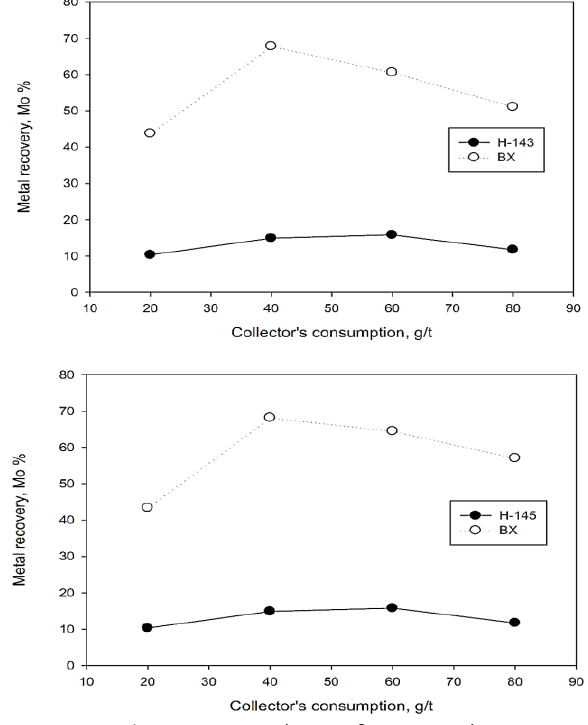
Figure 3. Dependence of H-143 and H-145 consumption on molybdenum metal recovery (%)